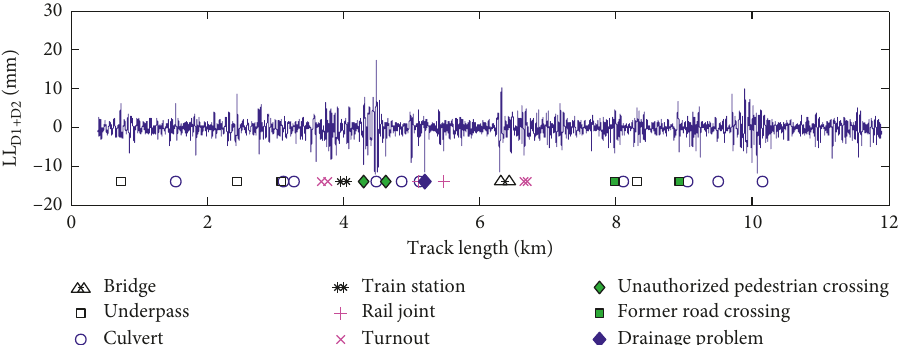
Figure 8: Track longitudinal level, in terms of the sum of the wavelength ranges D1 (3 < λ ≤ 25 m) and D2 (25 < λ ≤ 70 m), LL position of track discontinuities, often associated with track faults, below the longitudinal level plot.